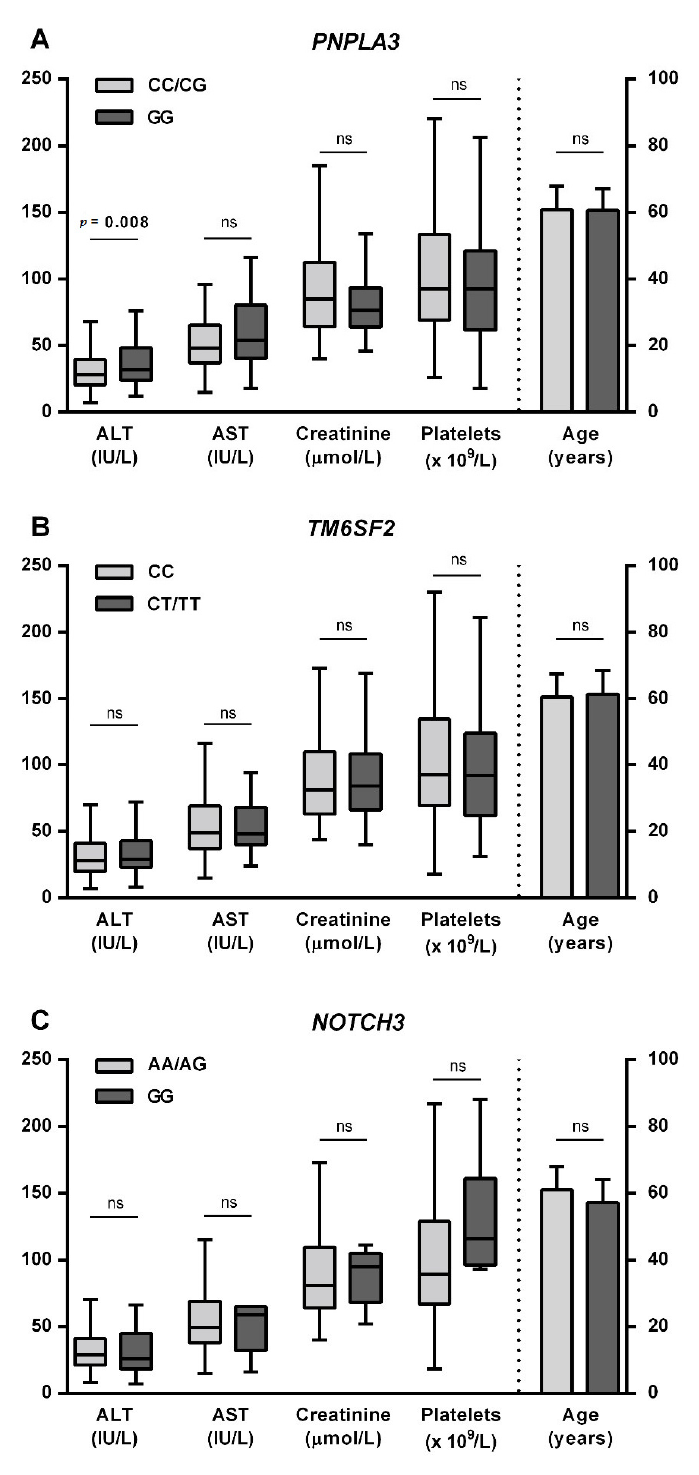
Figure 1. Association of SNPs with pre-transplantation parameters. Comparisons for ( A ) PNPLA3 , ( B ) TM6SF2 , and ( C ) NOTCH3 rs1043996 genotypes are shown. Alanine aminotransferase (ALT), aspartate transaminase (AST), creatinine levels, and platelets were not normally distributed and are presented as median with interquartile range; the Mann–Whitney-U test was used for statistical comparison. Age at transplantation was normally distributed; therefore, data are presented as mean with standard deviation and the Student’s t -test was used for statistical comparison. ALT— alanine aminotransferase; AST—aspartate transaminase; ns—not significant; PNPLA3 —patatin-like phospholipase domain-containing protein 3; TM6SF2 —transmembrane 6 superfamily member